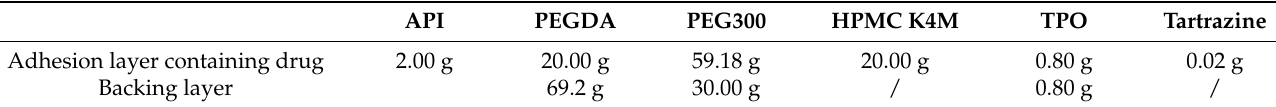
Table 6. Printing formulation of the bilayer oral